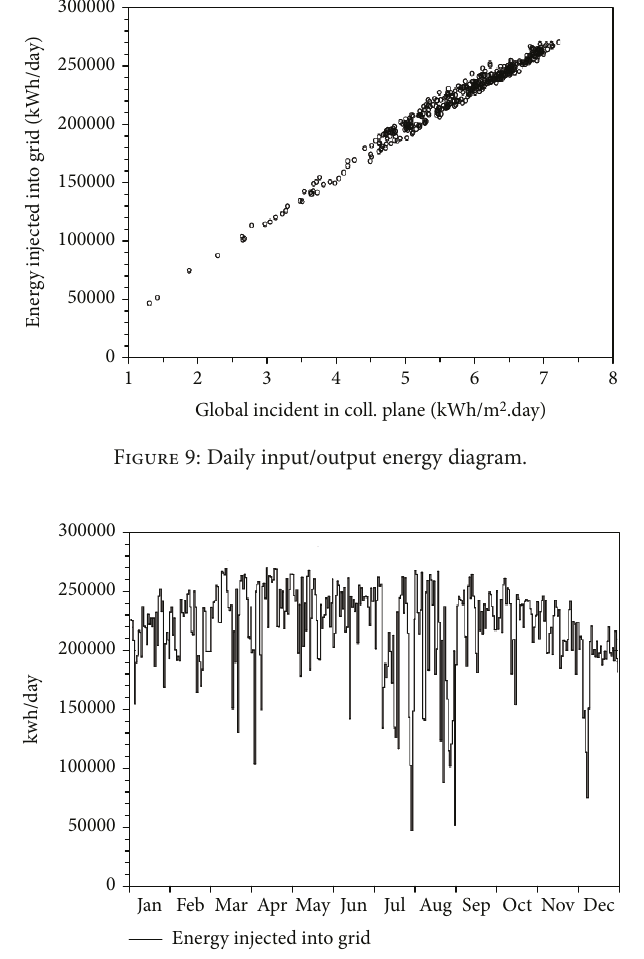
Figure 10: Energy injected into the grid monthly.